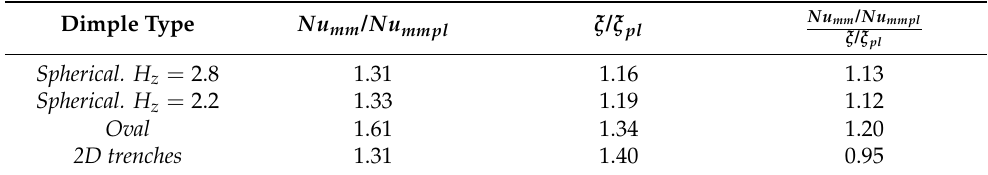
Table 2. Comparison of the heat transfer, hydraulic losses, and thermal-hydraulic efficiency of a channel section with two dimples.